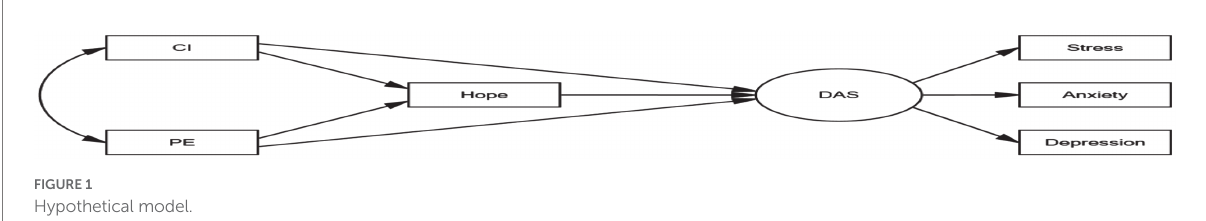
FIGURE 1 Hypothetical